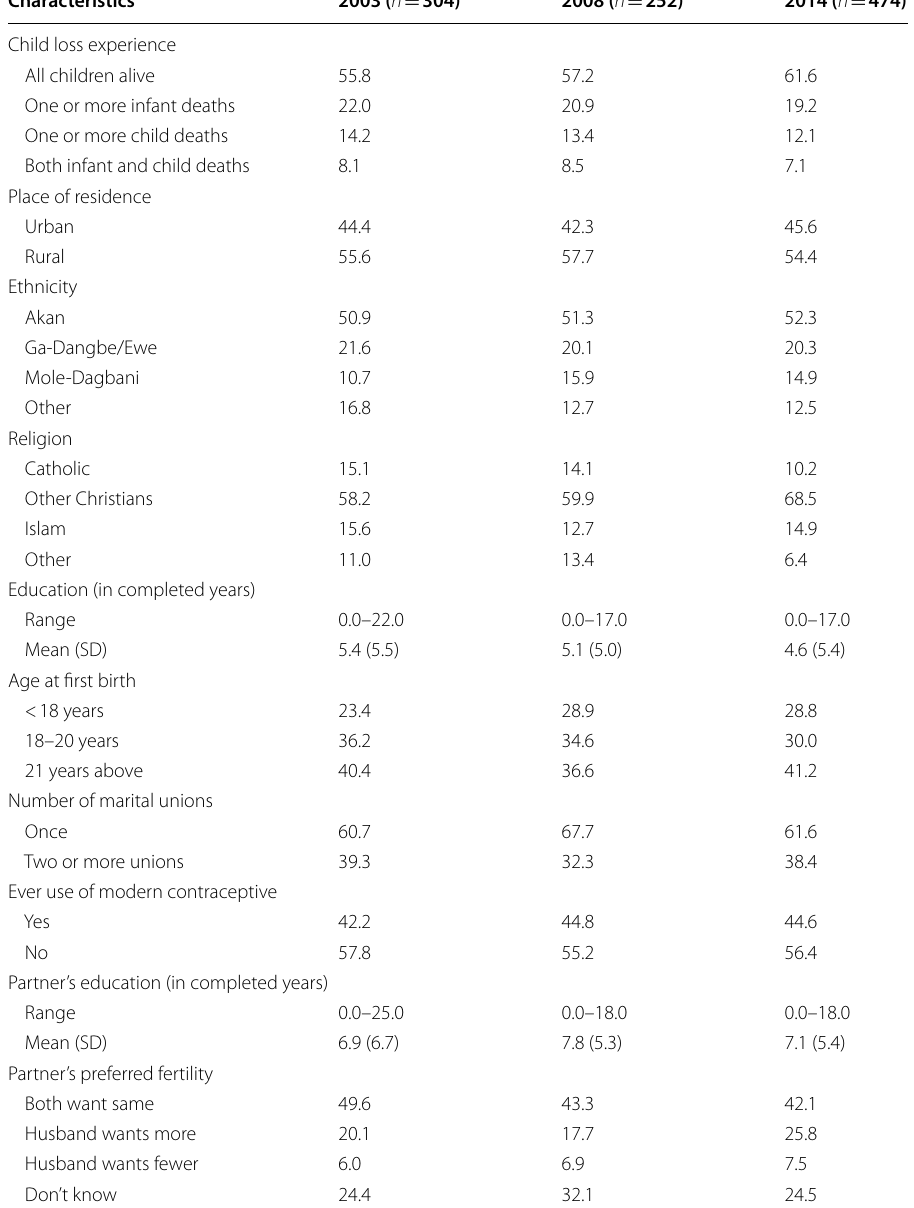
Table 1 Percentage distribution of women with completed fertility by socio‑demographic